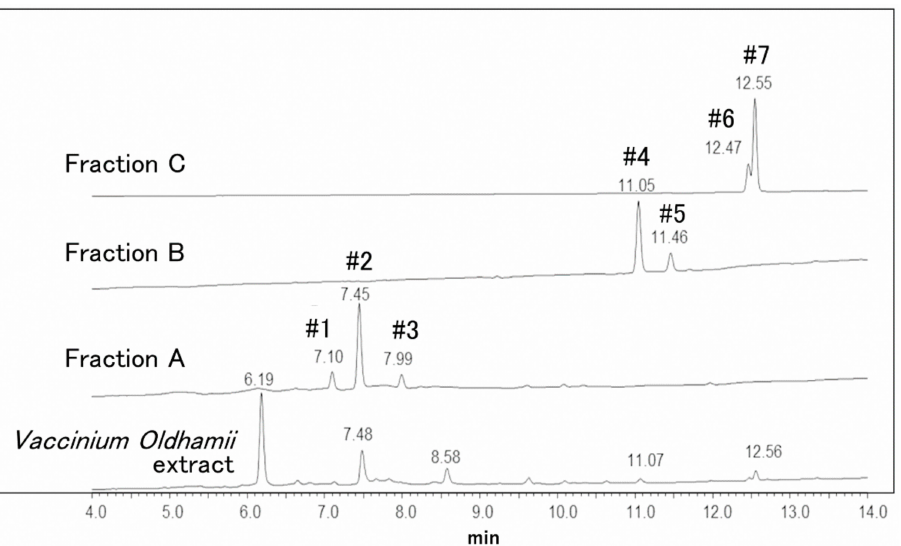
Figure 3. HPLC chromatograms for the fractions separated by electrospray ionization–liquid chromatography / mass spectrometry (ESI–LC /